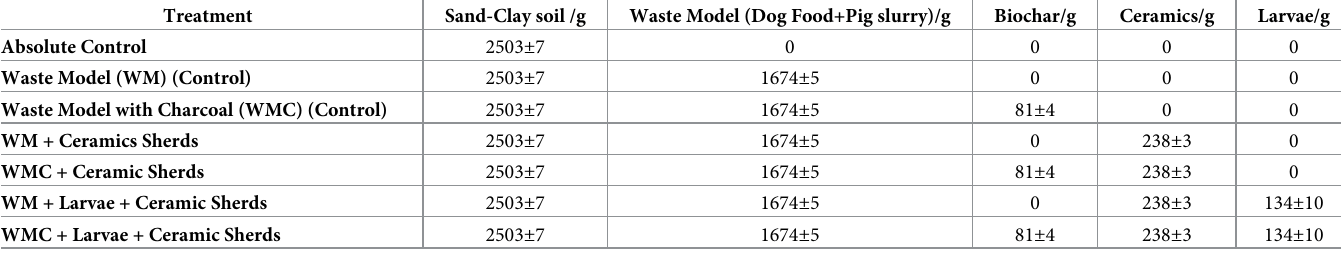
Table 1. Experimental